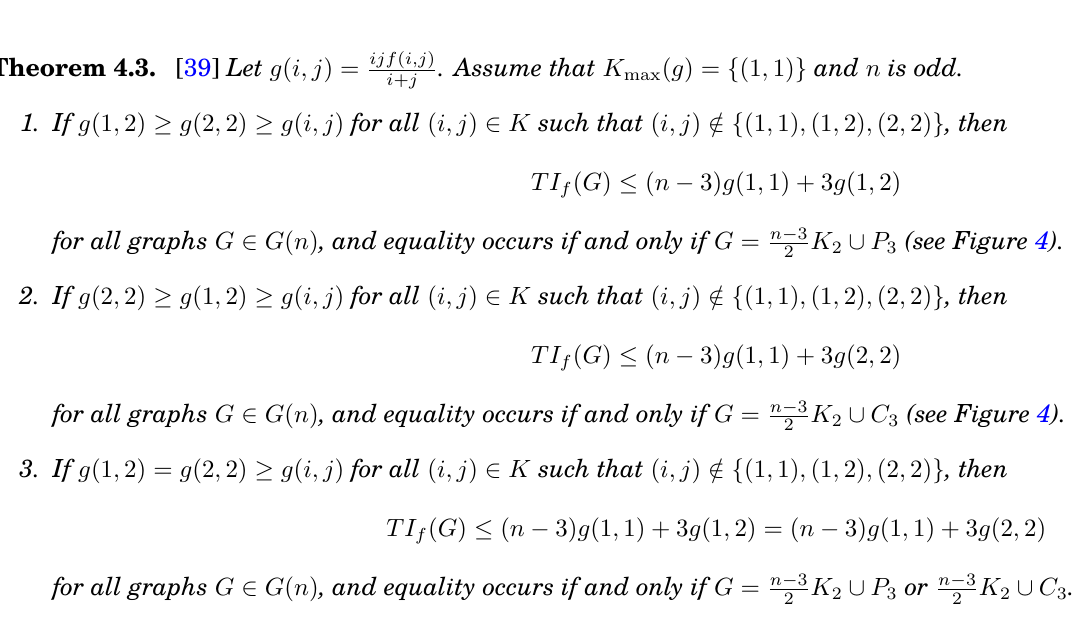
Figure 3: The minimal graph in Theorem